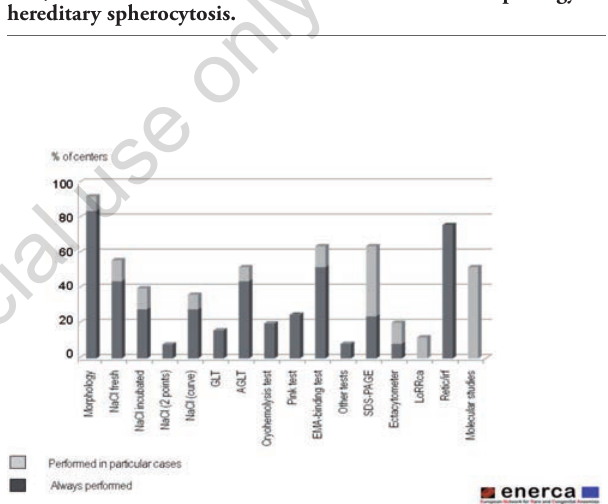
Figure 2. Use of diagnostic tests performed for diagnosis of red cell membrane defects.